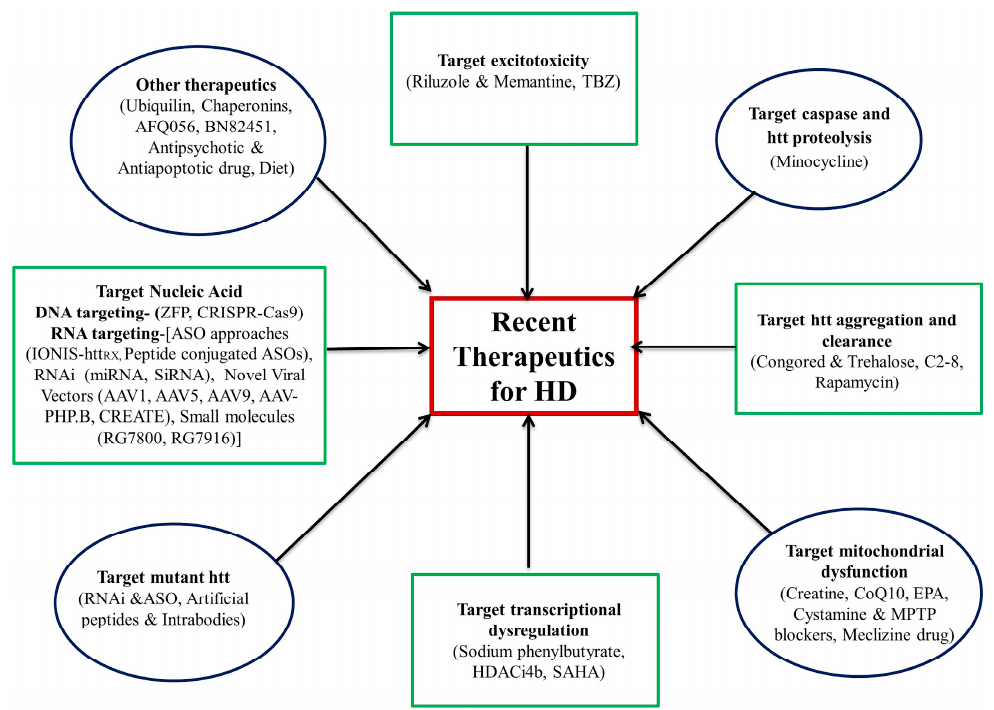
Figure 2. Recent advancement in the therapeutics for Huntington’s disease. TBZ (Tetrabenazine); EPA (eicosapentaenoic acid); MPTP (1-methyl-4-phenyl-1,2,3,6-tetrahydropyridine); SAHA (suberoylanilide hydroxamic acid); HDACi4b (histone deacetylase inhibitors); RNAi (RNA interference); ASO (antisense oligonucleotide); ZFP (zinc finger protein); CRISPR-Cas9 (clustered regularly interspaced short palindromic repeats); miRNA (micro RNA); siRNA (small interfering